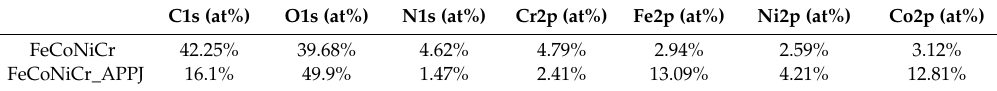
Figure 6. XPS survey scan spectra of ( a ) FeCoNiCr and ( b ) APPJ-treated FeCoNiCr. Table 2. Elemental ratios from XPS survey scan in Figure 6.